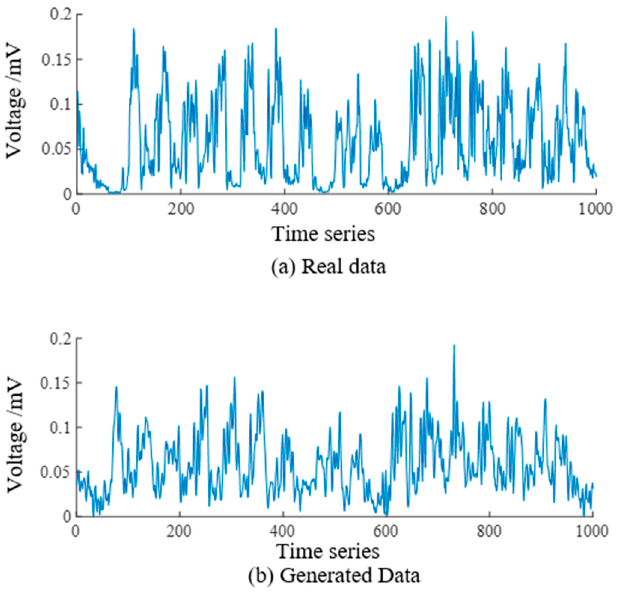
Figure 7. Comparison between real data and generated data.